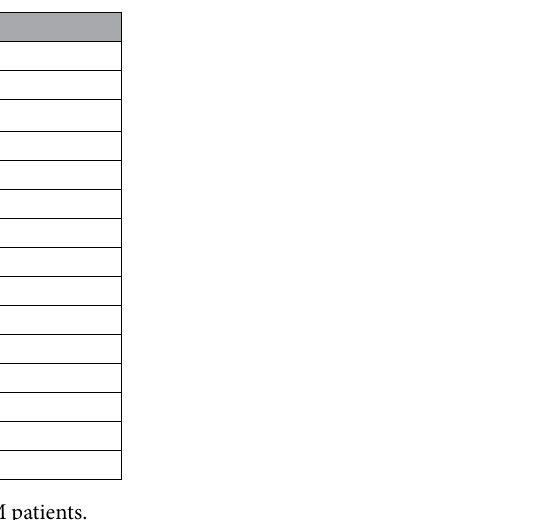
Table 1. Baseline characteristics of ORNM